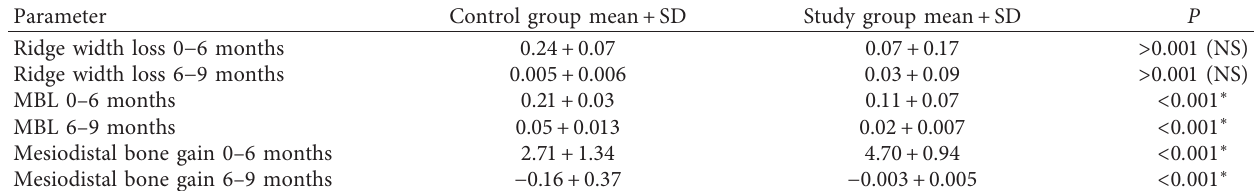
Table 2: Comparison between the two studied groups for osseous measurement in different observation periods.